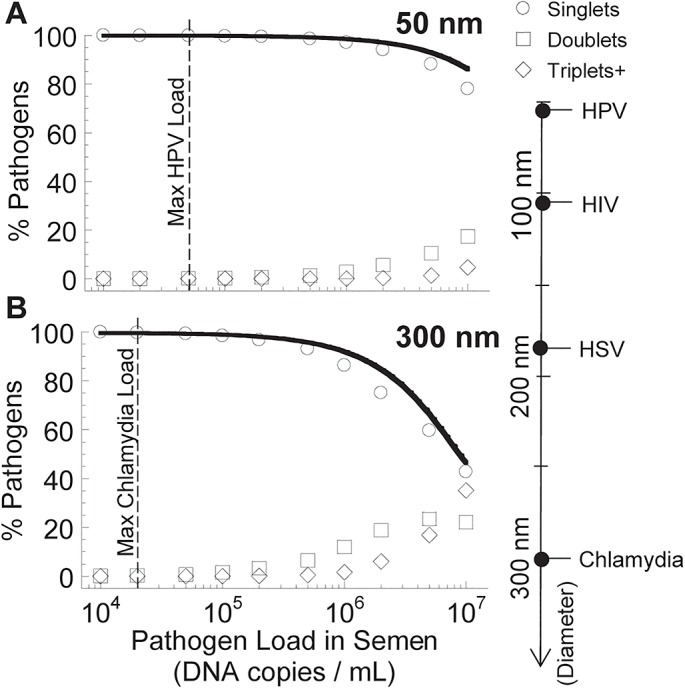
Estimating agglutination for pathogens of different size.Fraction of pathogens, (A) 50 nm and (B) 300 nm in diameter, that are predicted to diffuse from semen through CVM and reach the vaginal epithelium over the first 12 hours post semen deposition and which have undergone no collision (singlets), one collision (doublets) or two or more collisions (triplets+). The diffusivity of HPV in CVM is equivalent to that in buffer [17]; the diffusivity of Chlamydia, an obligate intracellular bacteria that lacks any active motility mechanism, is assumed to be the same in CVM as in buffer. The median and max HPV load in semen is 3.5 and 4.5 log10 copies per mL [18], whereas the median and max Chlamydia load in semen is 3.5 and 4.2 log10 copies per mL [19]. To enable rapid estimation of the viral load that may result in significant rates of agglutination, we also derived a mathematical equation (dashed curve; first summand of Eq 10) and utilized an exponential approximation (solid curve; Eq 3) that directly estimate the virion load arriving at the epithelial layer that experiences no collisions with other virions (see Appendix and S1 File).